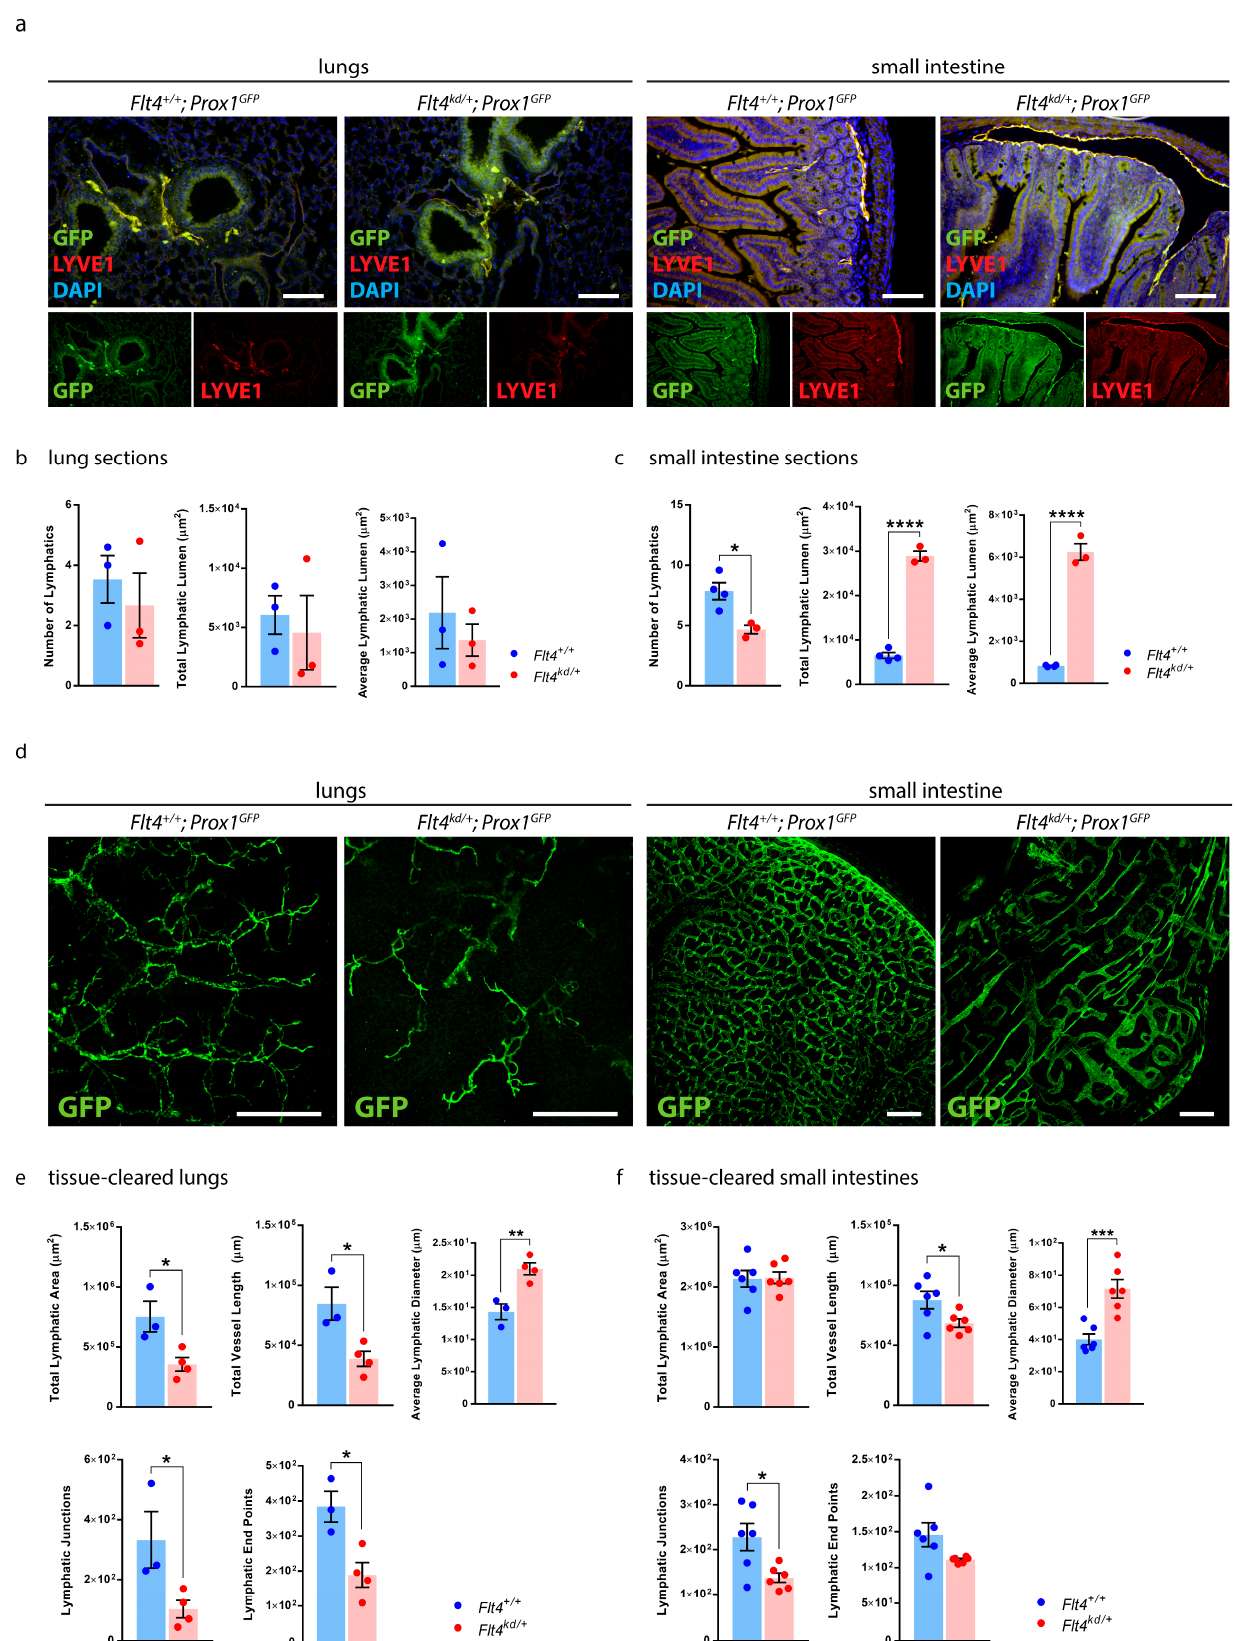
Figure 8. Quantification of the organ-specific lymphatic vasculature of Flt4 kd/+ Mice. ( a ) Visualization of the organ-specific lymphatic vasculature of the lungs and intestines of adult Flt4 +/+ ; Prox1 GFP